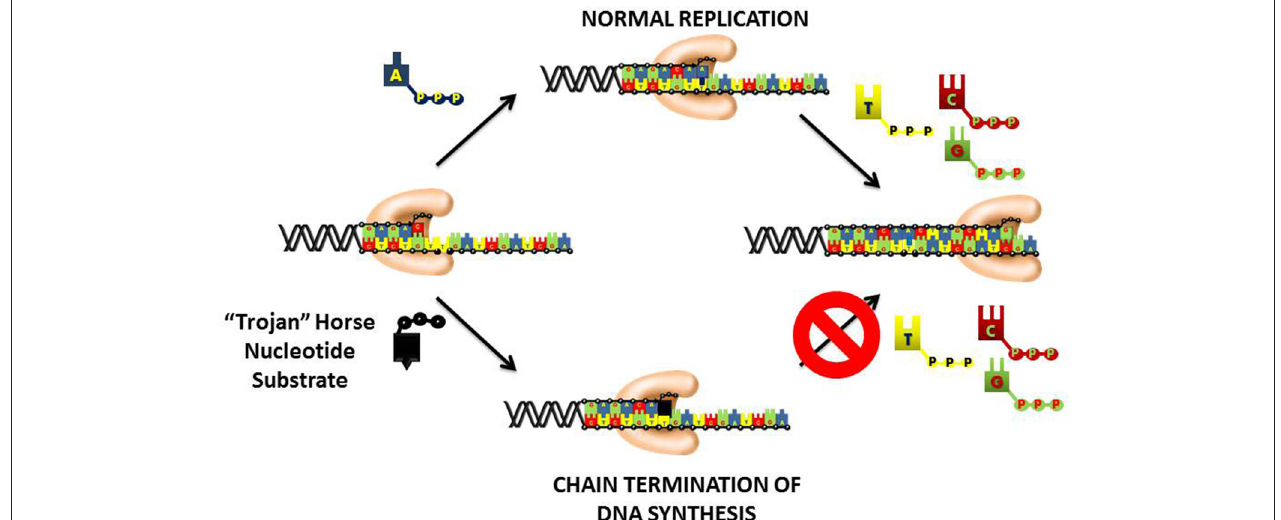
FIGURE 4 | “Trojan Horse” strategy of using nucleoside analogs to inhibit DNA polymerization. The polymerase is provided with a modified nucleotide in which the 3 ′ -OH group required for DNA elongation is missing, replaced with a halogen, or altered in configuration from a normal ribose sugar. Since the nucleobase component is left unmodified, the polymerase incorporates the nucleotide analog into DNA as efficiently as its natural counterpart. After incorporation, the nucleotide lacking a usable 3 ′ -OH group is refractory to elongation causing the induction of apoptosis by the termination of DNA synthesis.